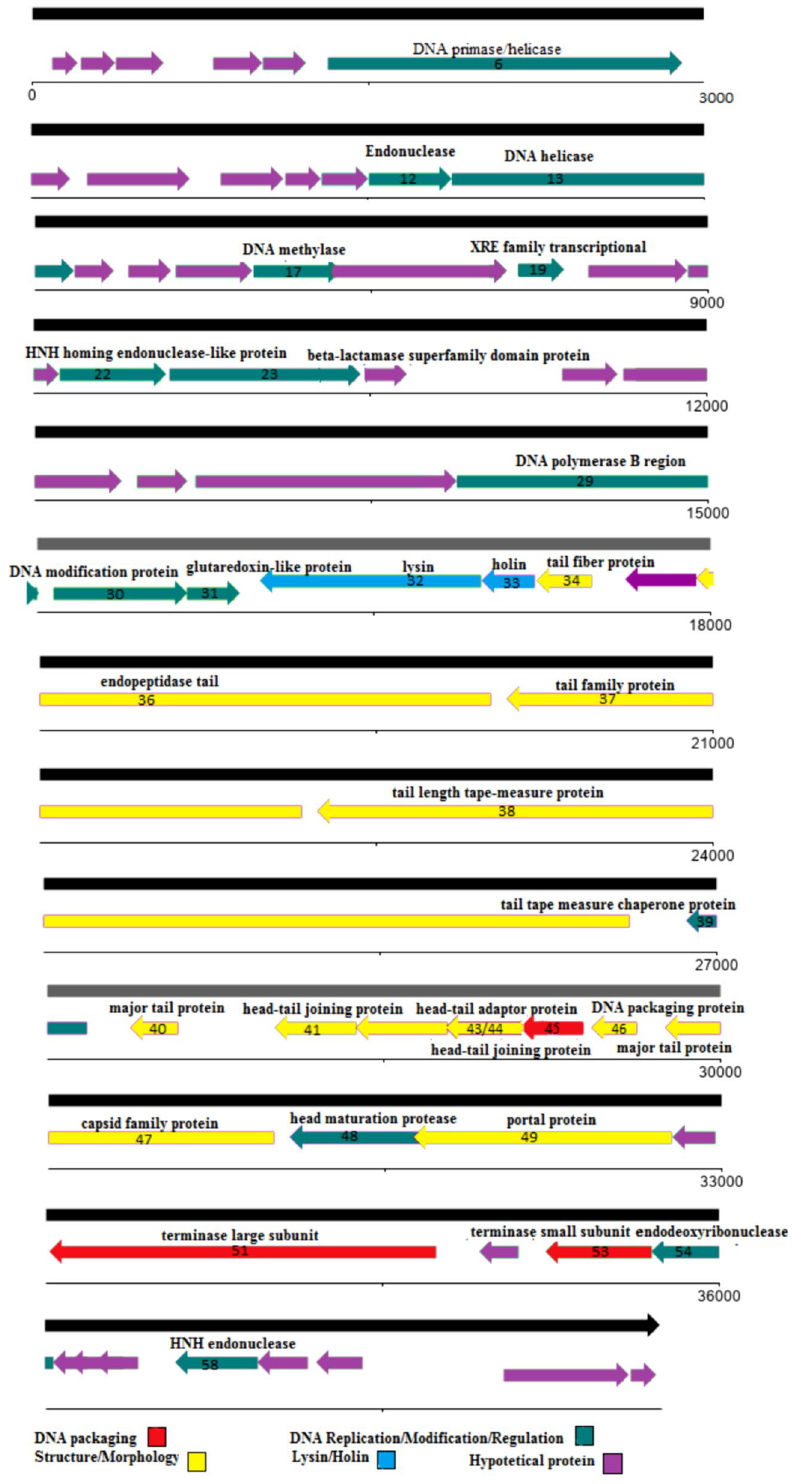
Figure 10. Genetic mapping of the vB_EfaS-SRH2 phage genome using DNA Plotter software. Arrows indicate the predicted 62 ORFs for this genome with their corresponding functions in different colors (red, green, purple, yellow, and